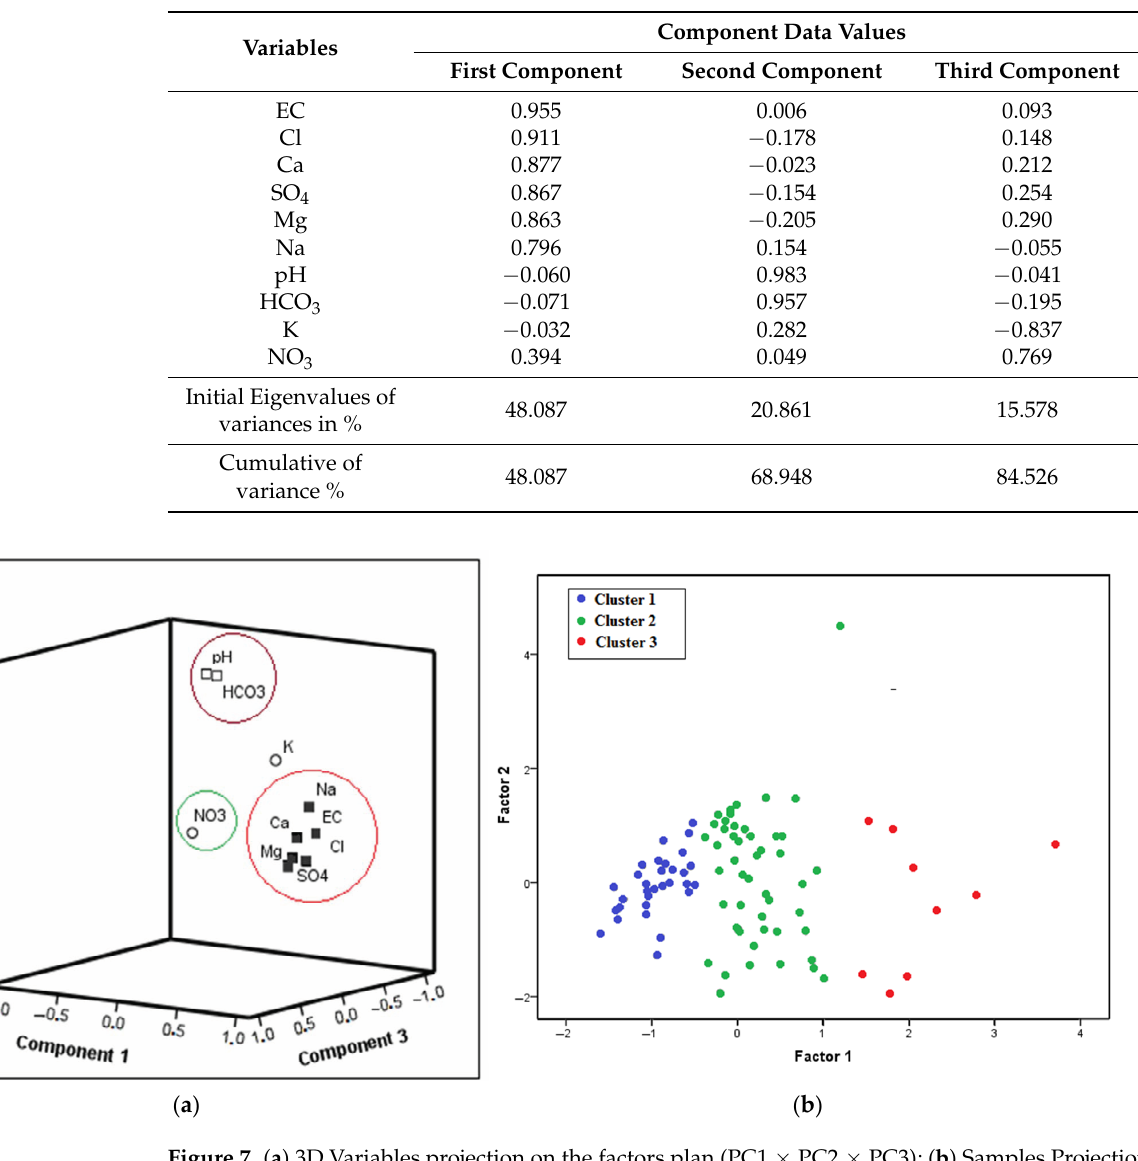
Table 2. The score of PCA after Varimax rotation.